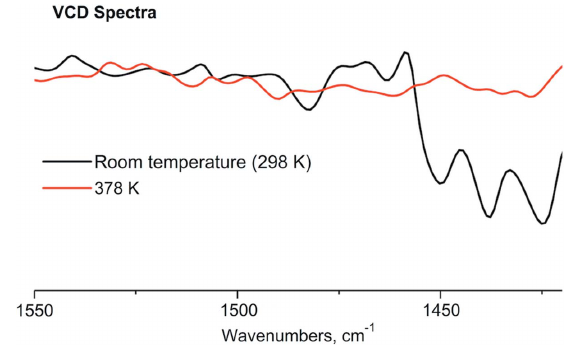
Figure 2 VCD spectra of 2PrBzIm crystals at room temperature in form I (black line) and after heating to 378 K in form II (red